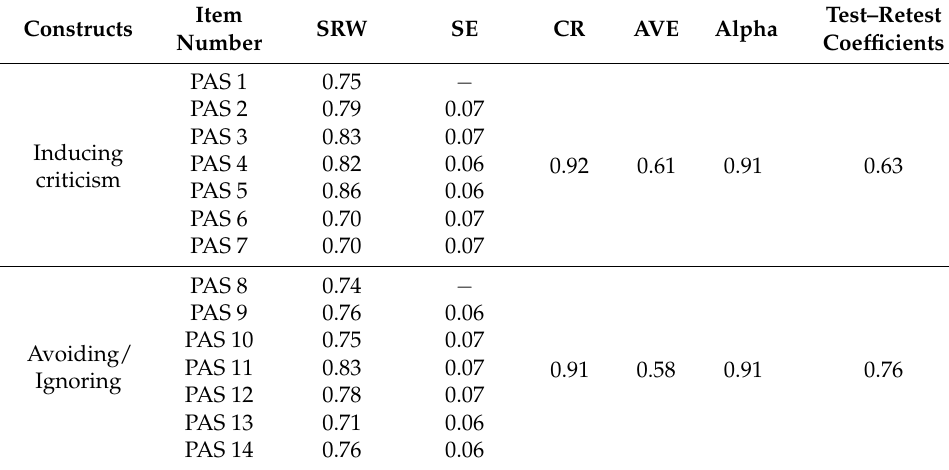
Table 3. Construct validity and reliability of